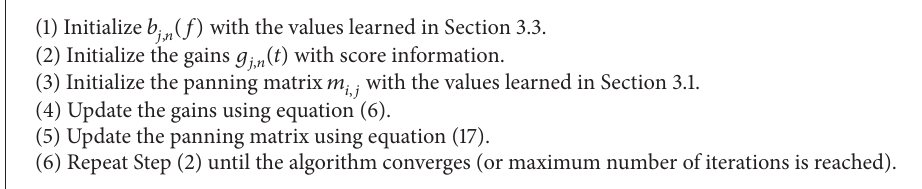
Algorithm 2: Gain estimation